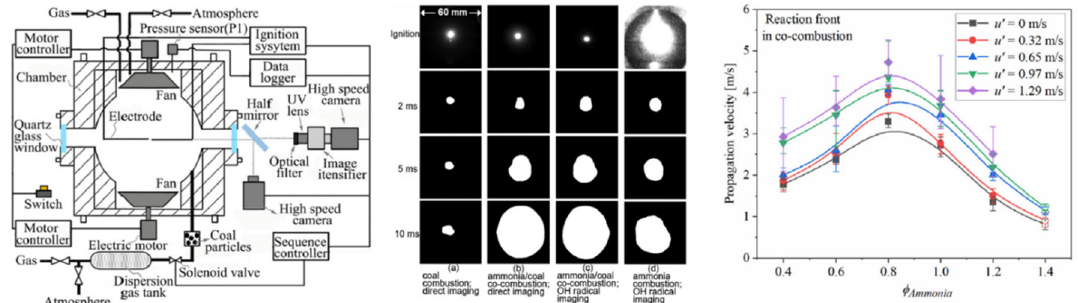
Figure 24. Experimental apparatus and results for obtaining the spherical propagation velocity of coal-NH 3 . Reaction front propagation velocities as φ NH3 under various turbulence intensity, u’ . Courtesy of Elsevier [113,114].